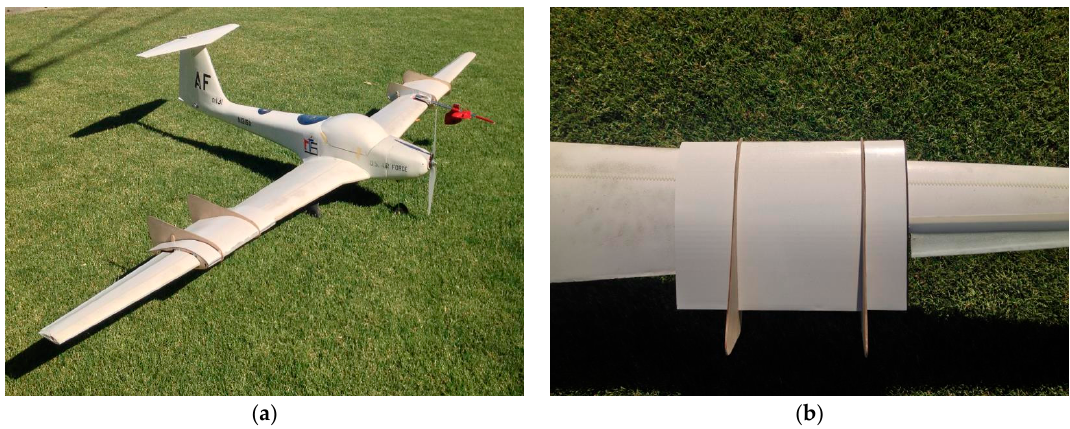
Figure 12. Wing glove with fences and constant chord extension. (Reprinted by permission of the American Institute of Aeronautics and Astronautics, Inc. (Reston, VA, USA) from [37]).